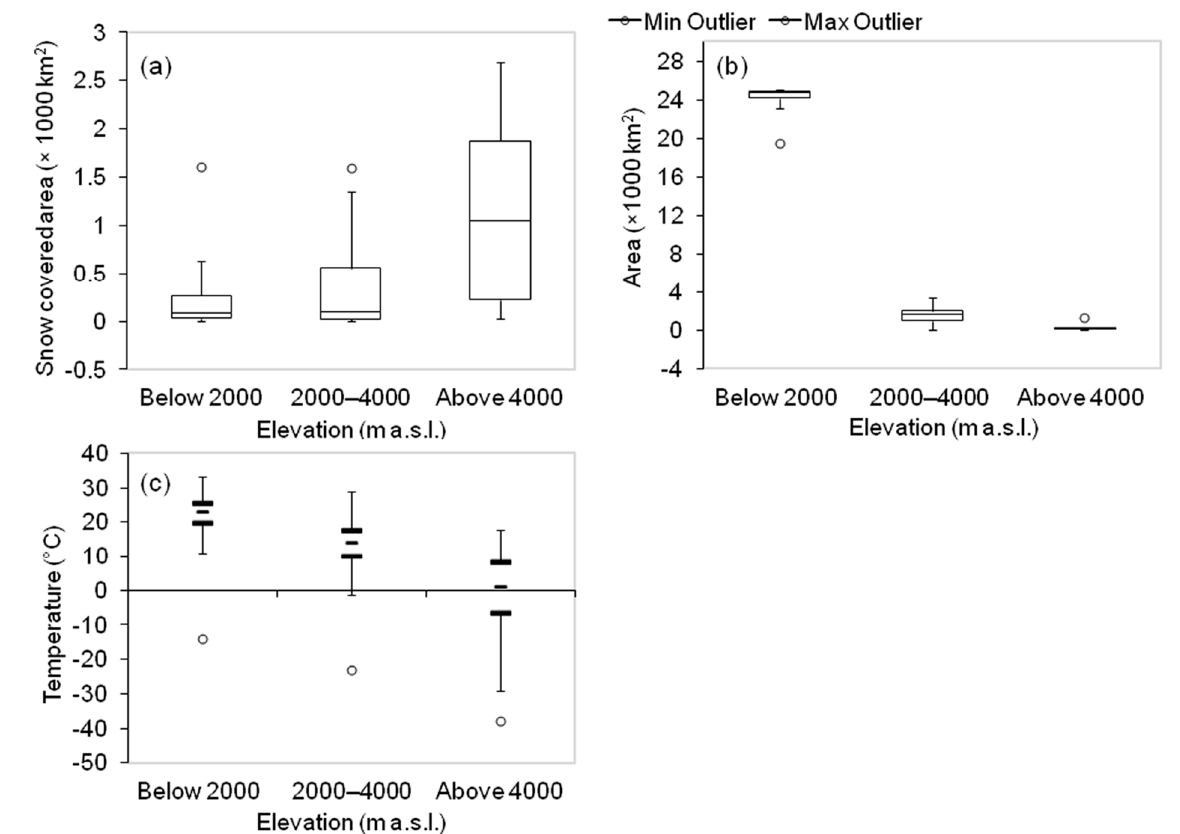
Figure 3. Boxplot displaying ( a ) area of NDVI grid layer ≥ 0.3 in different elevation zones, ( b ) area of snow cover in different elevation zones ( c ) temperature in different elevation zones in Uttarakhand. Circles show outliers and lines within boxes show median values.